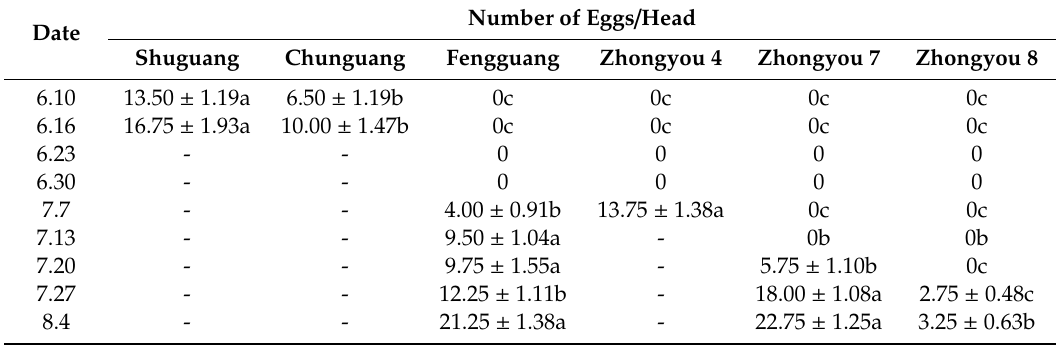
Table 1. The amount of eggs of D. suzukii on intact nectarine varieties on the same collection date.